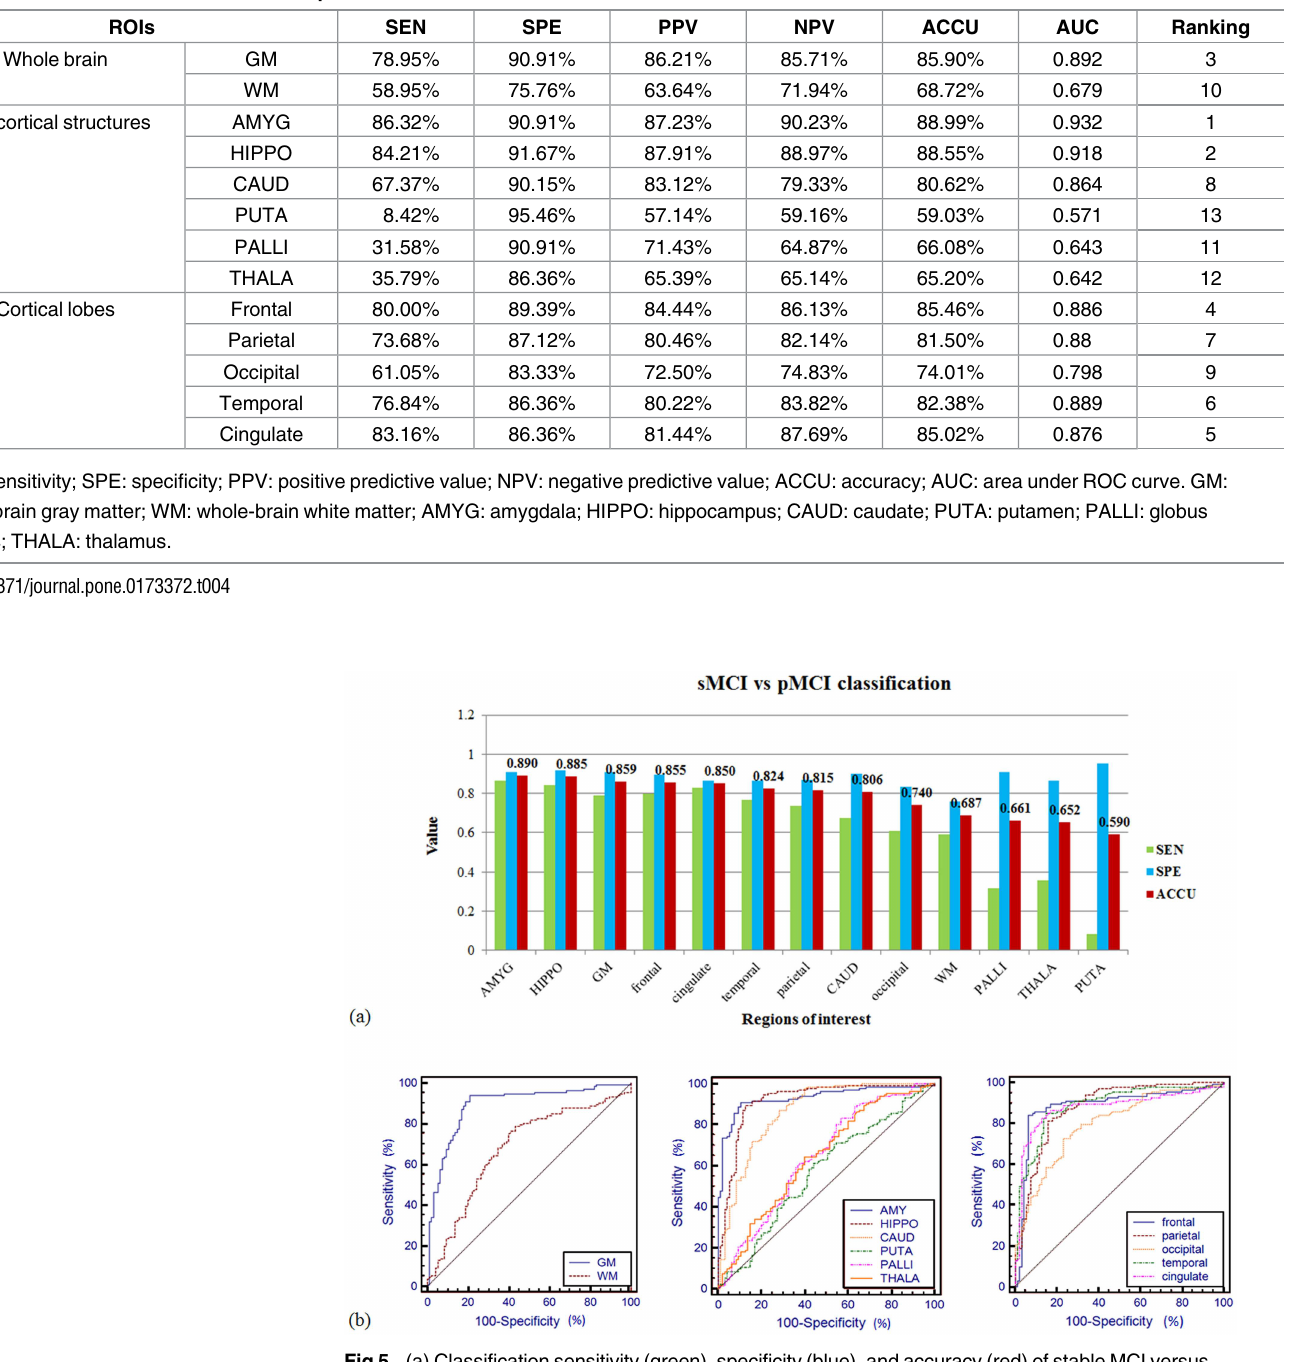
Table 4. Classification results of sMCI vs pMCI.